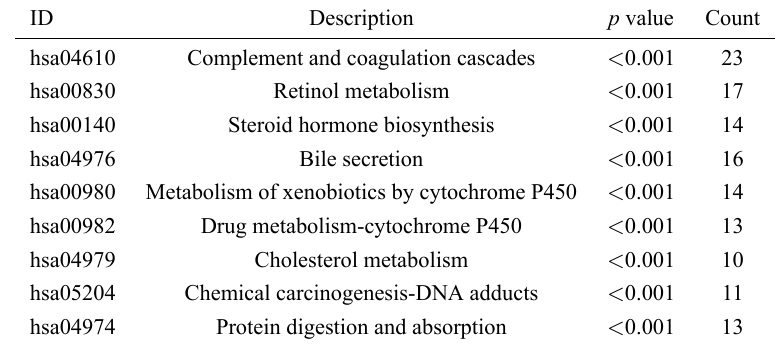
Table 2. Kyoto Encyclopedia of Genes and Genomes (KEGG) enrichment analysis of